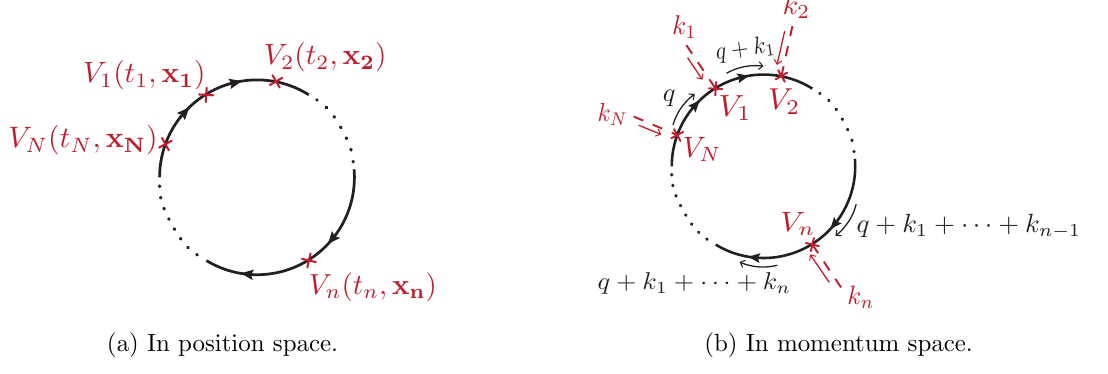
Figure 1. Illustration of a subdiagram consisting of a single scalar